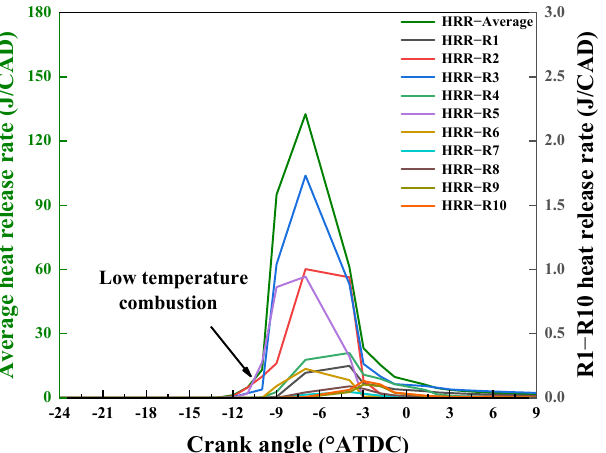
Figure 7. Comparison of the average in-cylinder heat release rate and local heat release rate of the ten regions under B20 working conditions.